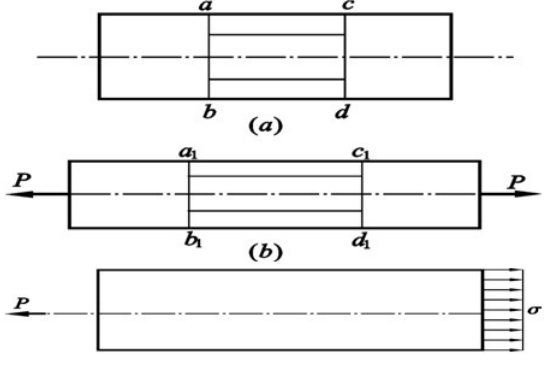
Fig. 5 Stressed cross section of rod